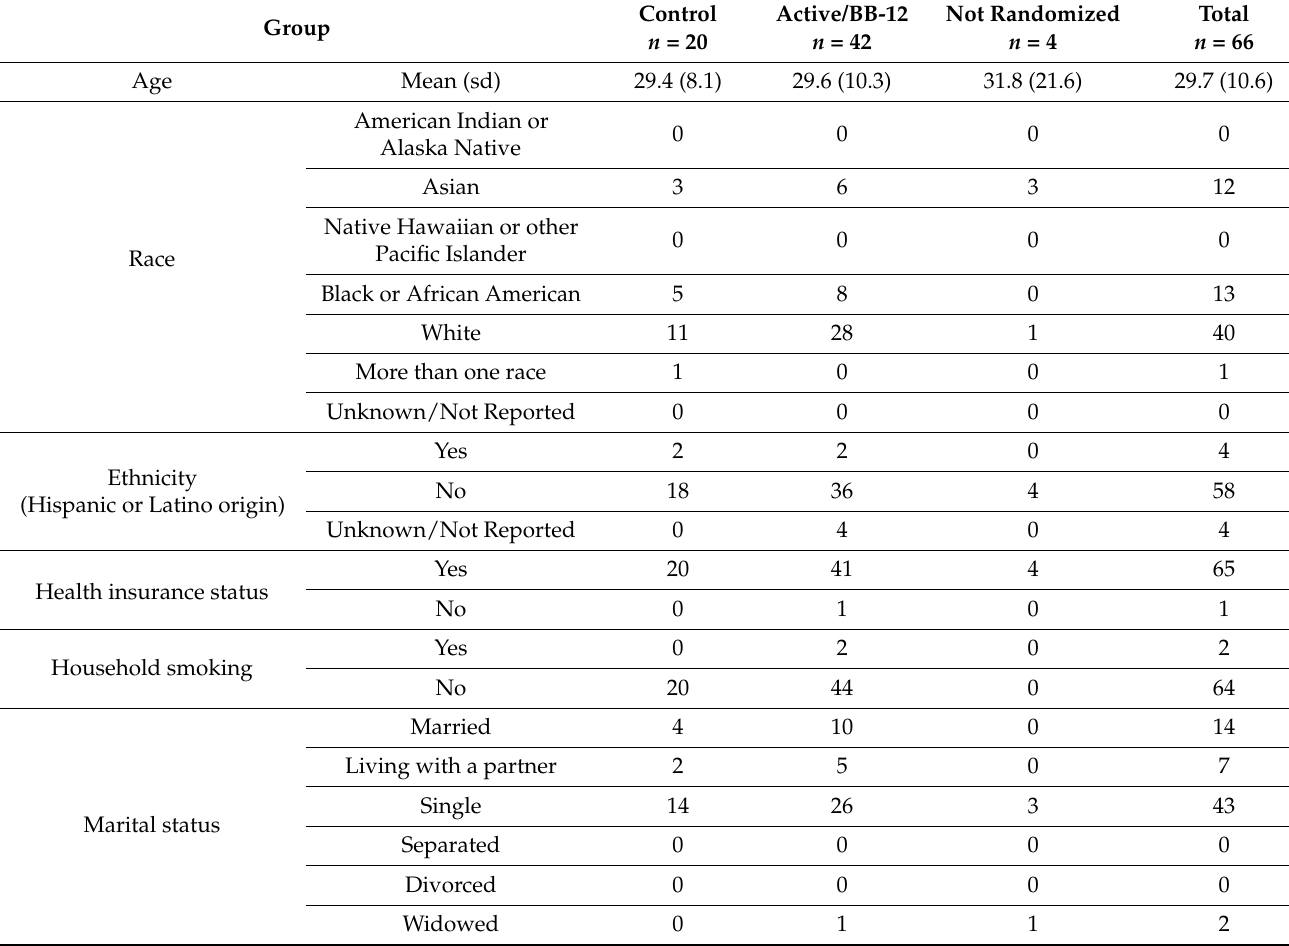
Figure 2. Consolidated standards of reporting trials (CONSORT) flow diagram of participants. Sixty-six participants were enrolled, 62 of which were randomized (42 to BB-12 group and 20 to control) after a 30-day run-in period. By day 7 of the intervention, 56 participants (38 BB-12 and 18 control) remained in the study. Table 1. Participant characteristics by group assignment.